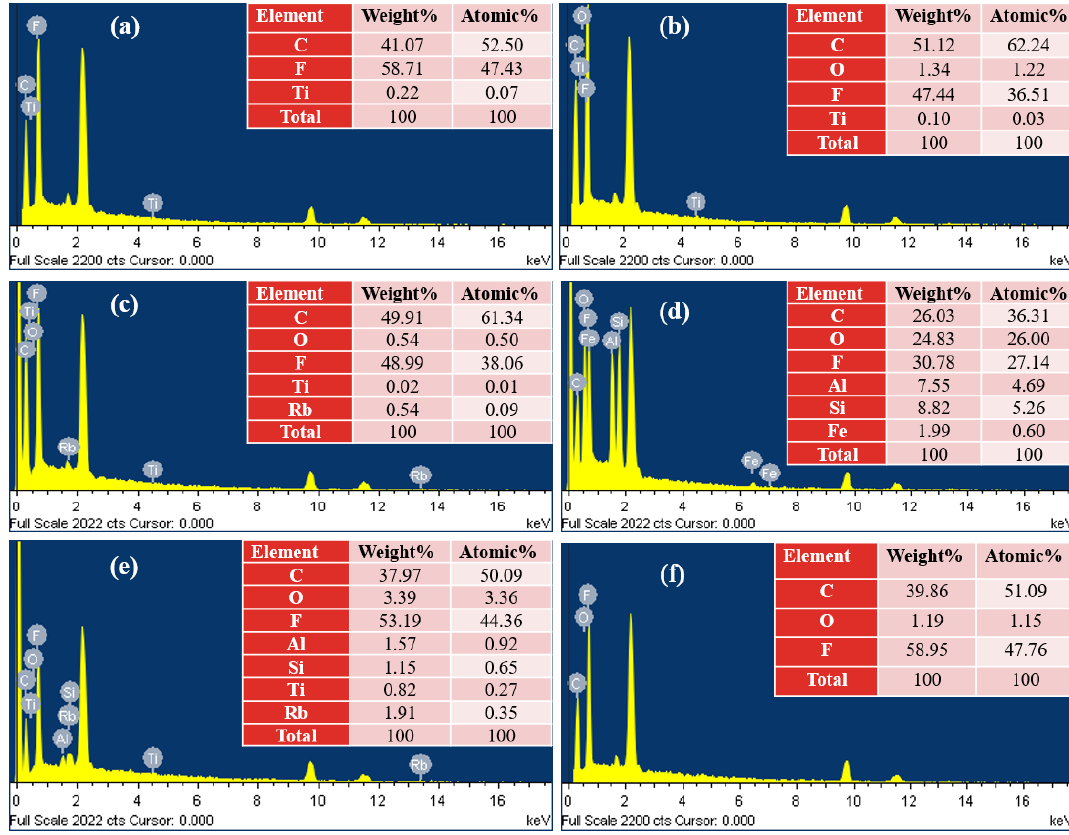
Figure 3. Elemental composition analysis of representative membrane samples: ( a ) PVDF-neat, ( b ) PVDF-1 on Day 7, ( c ) PVDF-2 on Day 28, ( d ) PVDF-4 on Day 56, ( e ) PVDF-8 on Day 84 and ( f ) PVDF-15 on Day 112.